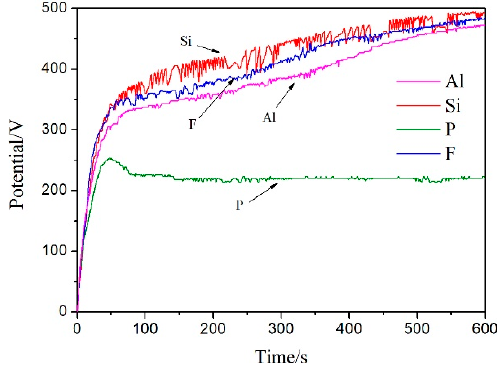
Figure 1. Voltage vs. time plots.